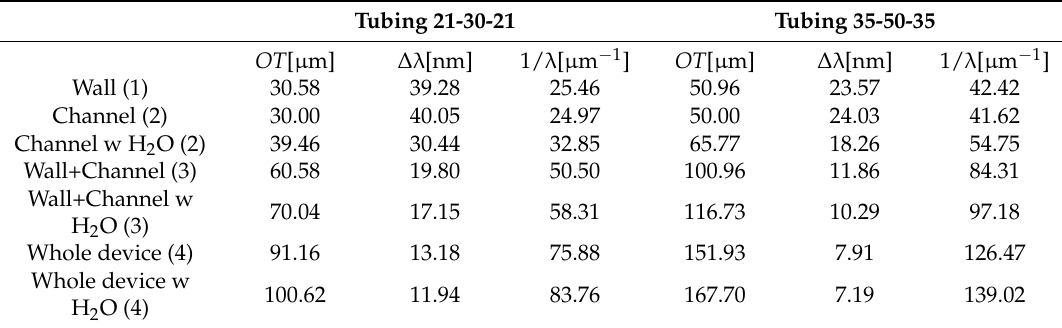
Table 1. Theoretical values of OT , ∆ λ and 1/ λ for both tubing dimensions (nominal values), with and without H 2 O filling.